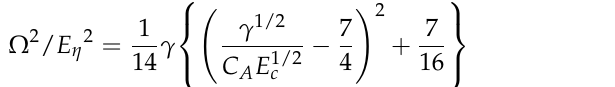
Figure 2. The stopping powers and the electronic LET for Pb ions: ( a ) in argon; ( b ) in xenon. LET el was obtained by using a semi-empirical power-law approximation for q nc